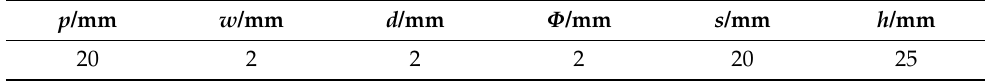
Table 2. Unit parameter values of Warren